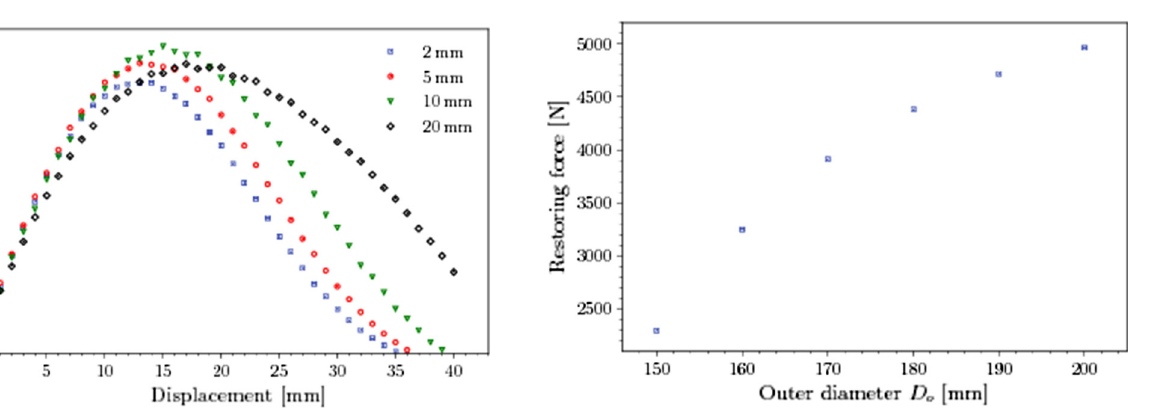
Fig. 5 Maximum coupling for drive magnets with an inner diameter of 140mm and varying outer diameters